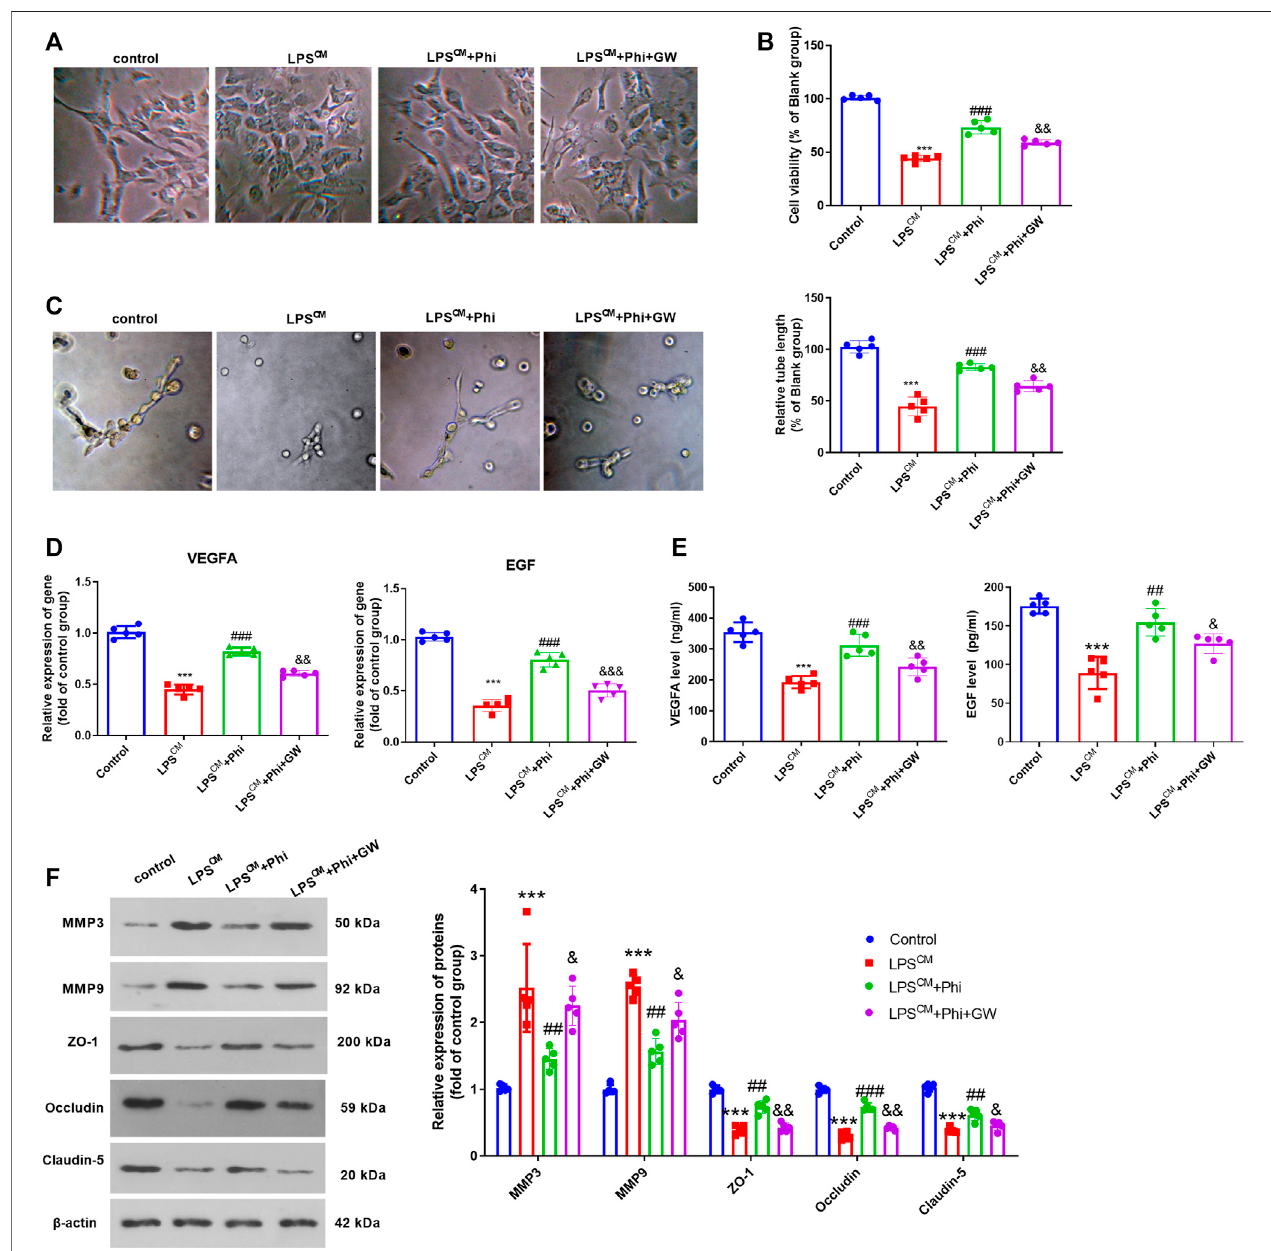
FIGURE 5 | Phi promoted BMECs viability and tube formation ability via PPAR γ in BMECs. BMECs were treated with the culture medium from LPS-mediated microglia, Phi (40 μ g/ml) and/or GW9662. (A) Morphological changes of BMECs were recorded using a light Olympus microscope. (B) Cell viability of BMECs was detected by CCK-8 assay. (C) Tube formation assay was performed to evaluate the tube formation ability of BMECs. (D , E) RT-PCR and ELISA were conducted to measureVEGFAandEGFinBMECsortheculturemedium. (F) ExpressionsofMMP3,MMP9,ZO-1,occludin,andclaudin-5inBMECswereevaluatedviaWestern blot.Thevaluesareexpressedasmean ± SD.*** p < 0.001vs.thecontrolgroup;## p < 0.01,### p < 0.001vs.theLPS-CMgroup;& p < 0.05,&& p < 0.01,&&& p < 0.001 vs. the LPS-CM +Phi group. n (cid:1)